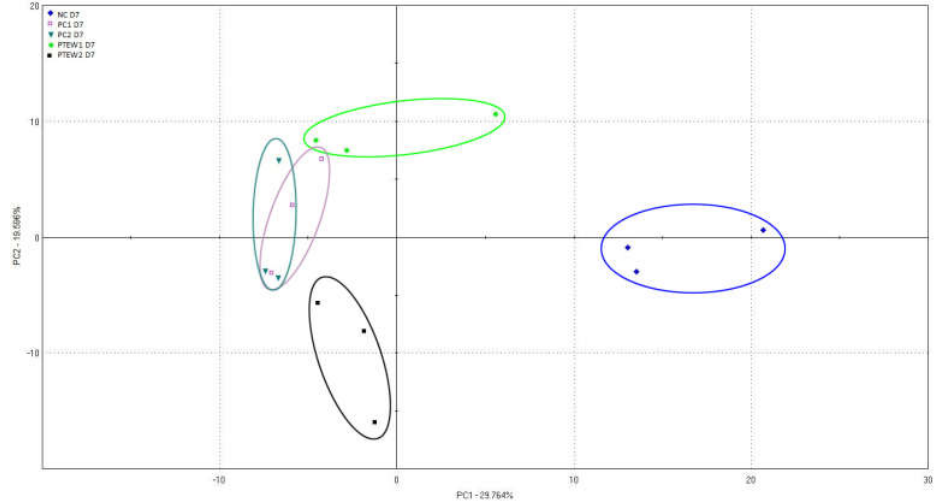
Figure 6. Principal component analysis of liver pâtés—day 7; NC—negative control (liver pâtés without nitrite source); PC1—positive control (liver pâtés with 60 ppm of sodium nitrite); PTEW1— liver pâtés with plasma-treated egg white containing 40 NO 2− ; PC2—(liver pâtés with 120 ppm of sodium nitrite); PTEW2—liver pâtés with plasma-treated egg white containing 80 NO 2− .